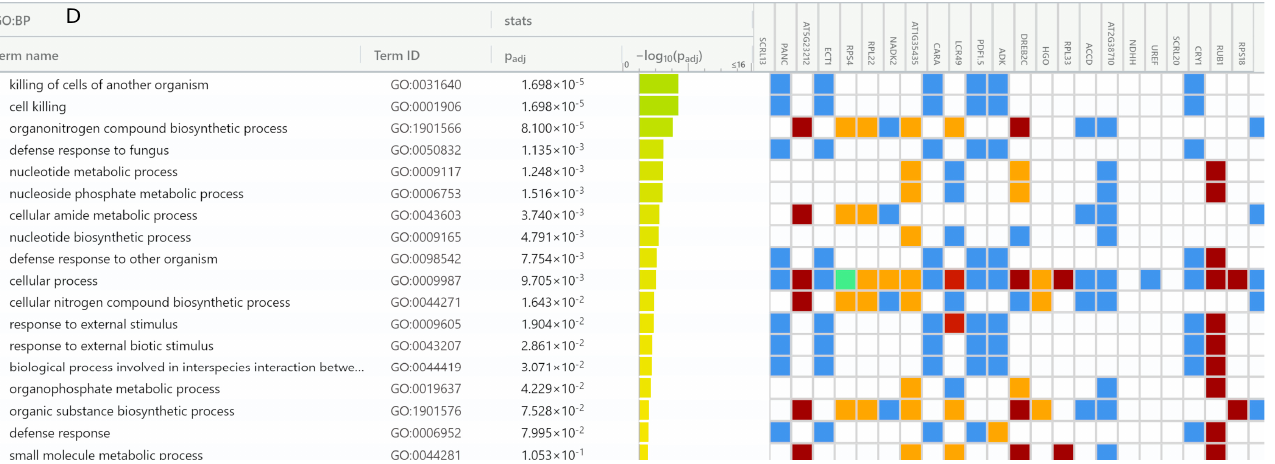
Figure 8. H. sapiens and A. thaliana gene set enrichment analysis of AFP 14–20 -like motif-containing proteins. Human genes categorized in ( A ) molecular function terms and ( B ) biological process terms. A. thaliana genes categorized in ( C ) molecular function terms and ( D ) biological process terms. Color codes indicate data inferred from: dark brown—experiment/direct assay, light